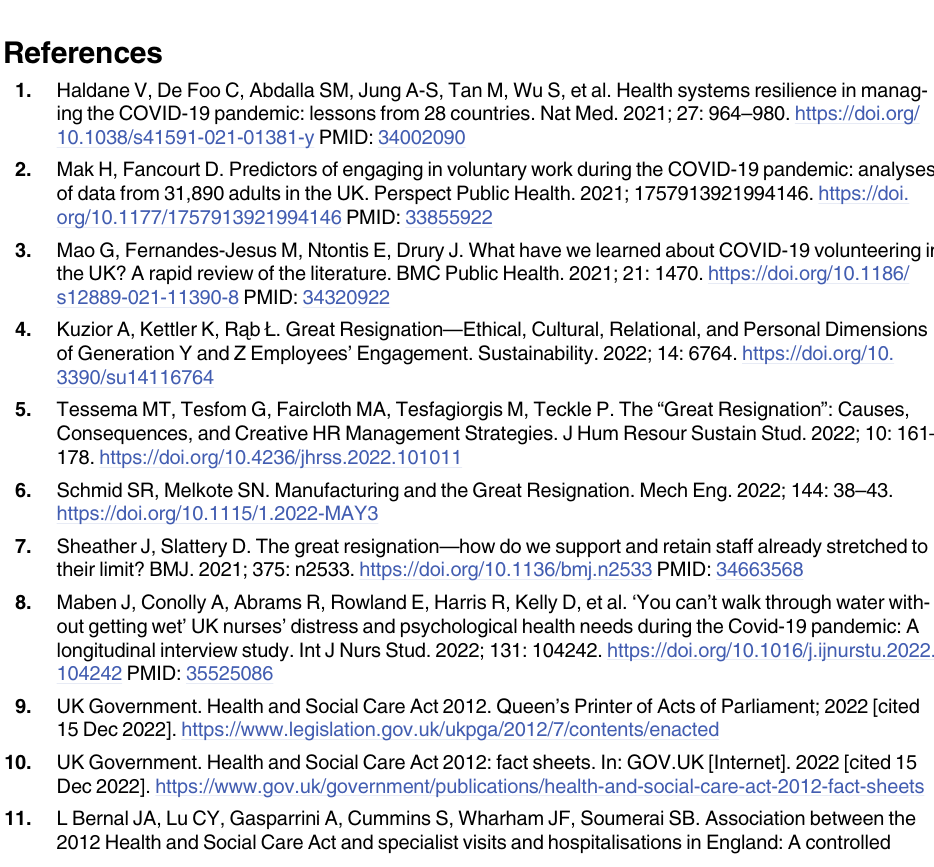
S1 Fig. Estimated job related feelings of people in the healthcare sector over the past decade, relative to other public sector workers, and private sector workers.